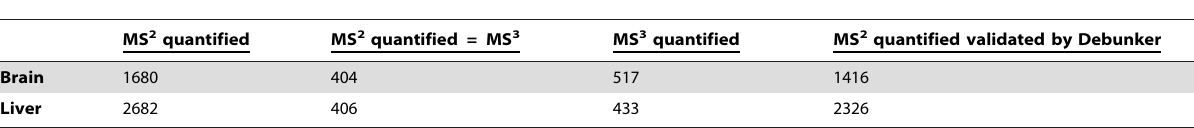
Table 3. Validation of quantified phosphopeptides with MS 3 spectra and Debunker.